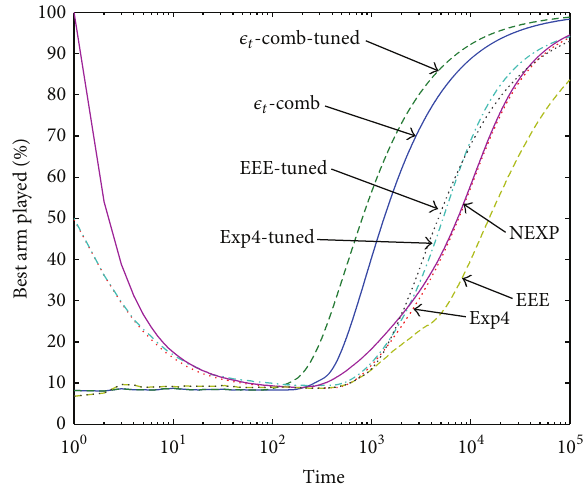
Figure 2: Percentage of plays of the optimal arm of (tuned) 𝜖 𝑡 - comb(3 𝜖 𝑡 -greedy strategies) and of (tuned) Exp4/NEXP/EEEs for the distribution ( 0.9, 0.8, 0.8, 0.8, 0.7, 0.7, 0.7, 0.6, 0.6, 0.6 ).